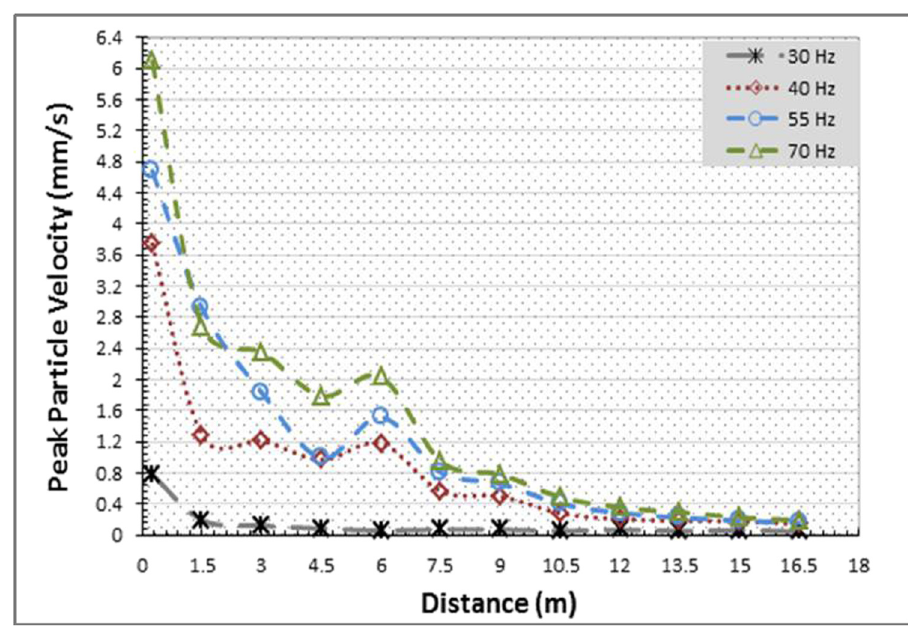
Figure 6: Attenuation of vibration velocity for various frequencies ( no wave barrier ) .